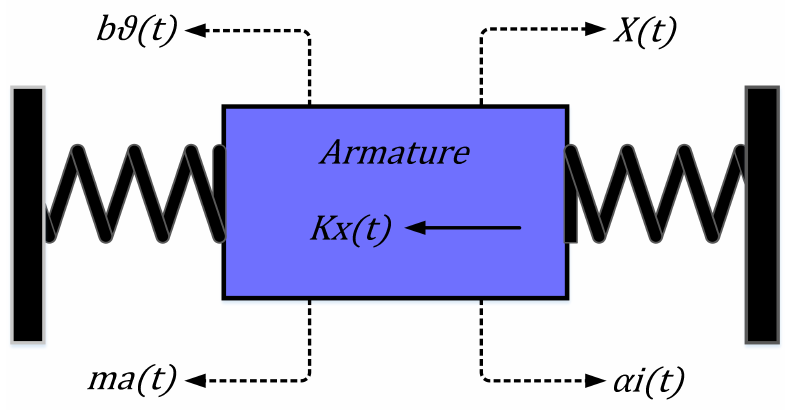
Figure 15. Mechanical system of proposed